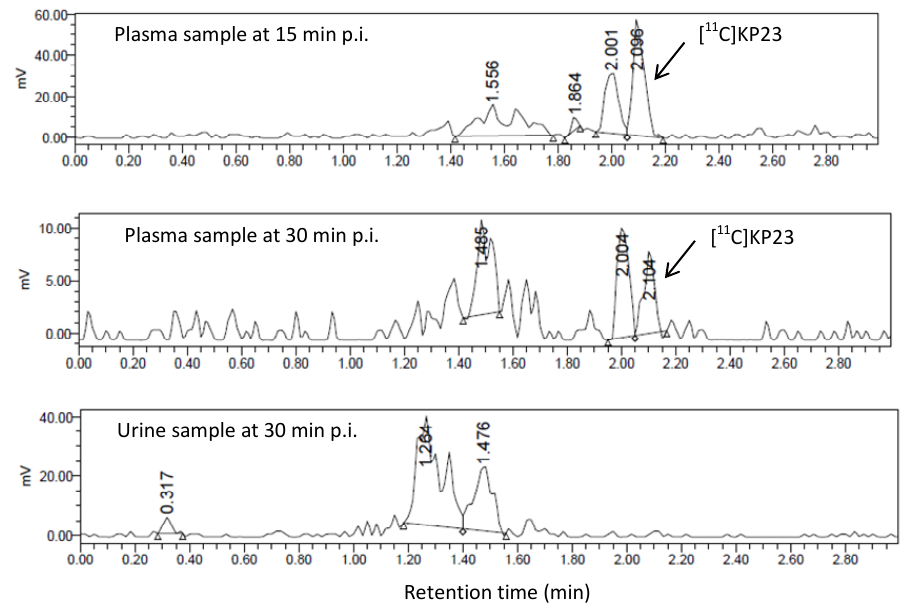
Figure 5. Radio-UPLC profiles of [ 11 C]KP23 metabolites in blood plasma samples obtained at 15 min and 30 min p.i. and in the urine sample obtained at 30 min